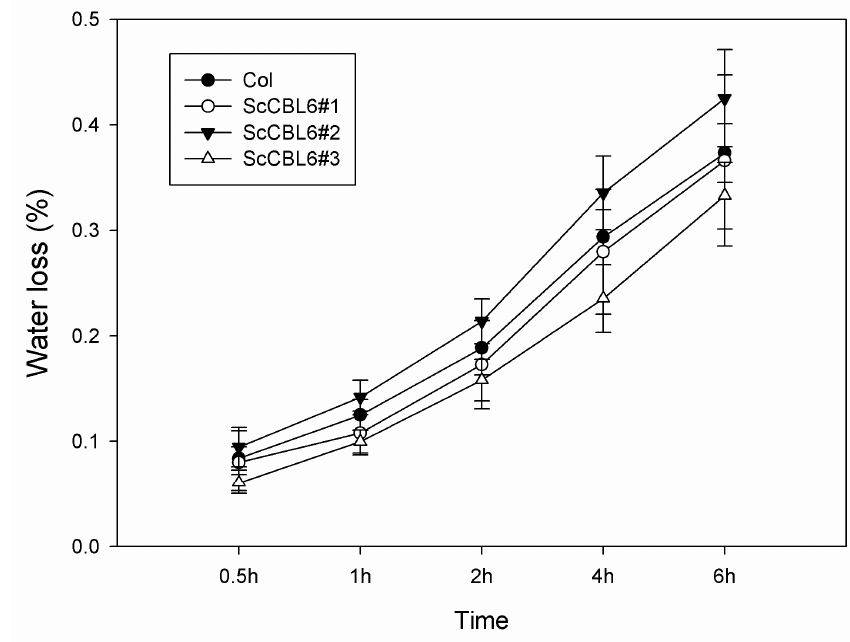
Figure 3. Water loss rate of ScCBL6 -OXP and WT leaves. The water loss rate was calculated as the difference between weights at individual timepoints and the original weight. Col, Columbia ecotype Arabidopsis ; numbers followed by # denote different transgenic lines of ScCBL6 -OXP.